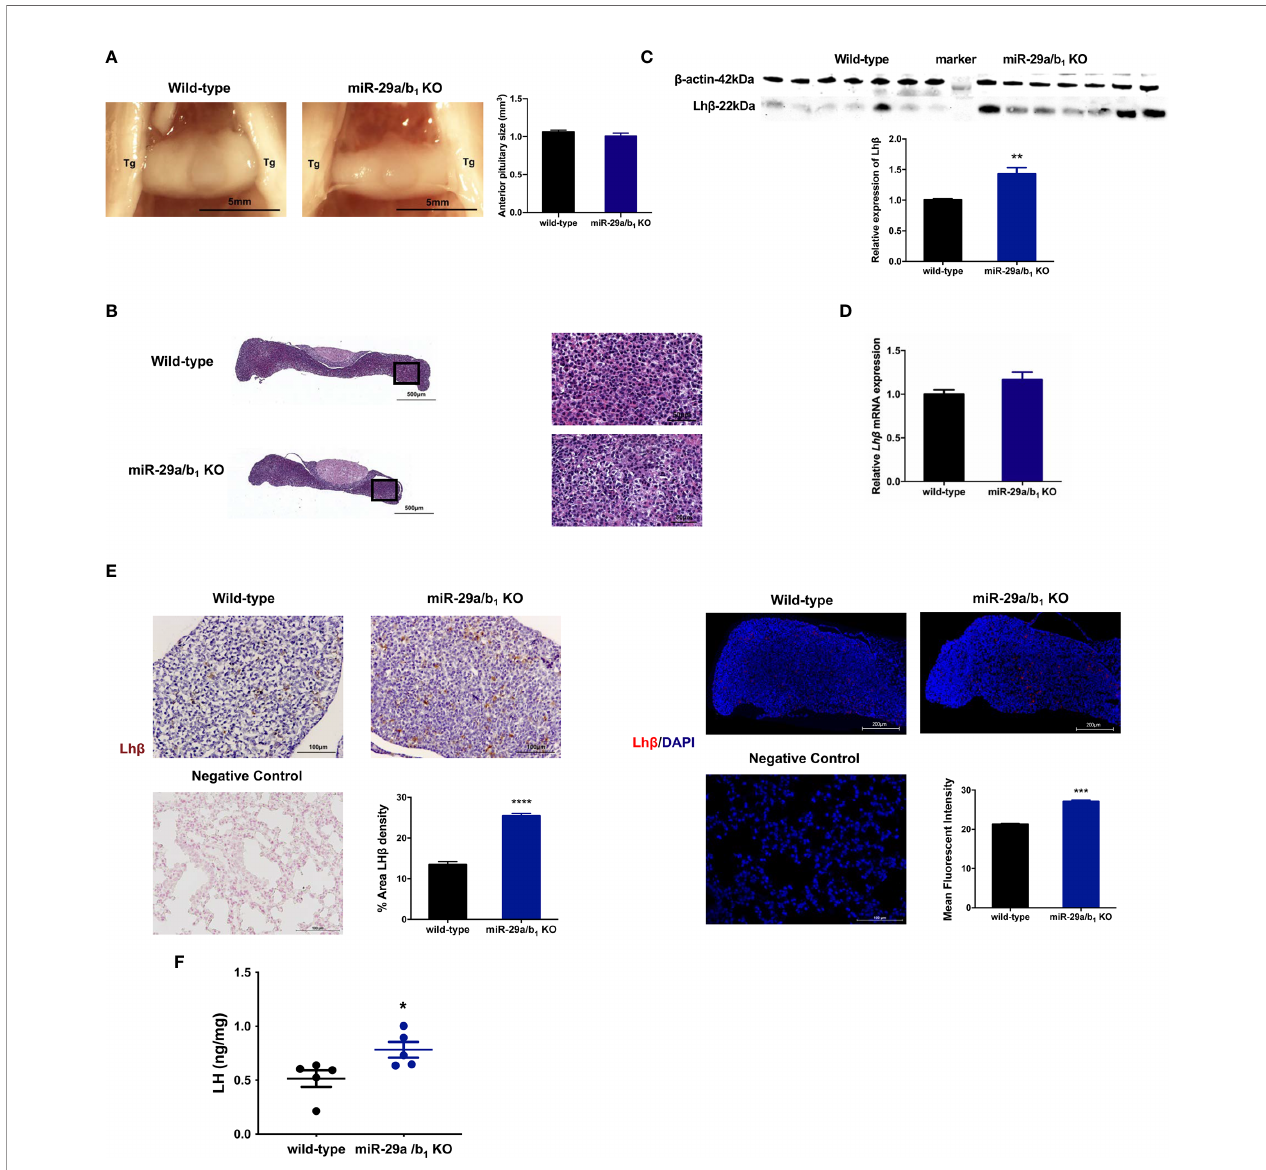
FIGURE 6 | Impairment of Lh b protein export in the pituitary as a de fi ciency of miR-29a/b 1 . (A) Pituitary from female wild-type mice (n=9) and miR-29a/b 1 KO mice (n=5) were photographed in situ during dissection. Trigeminal nerves that fl ank the pituitary are marked as Tg. Scale bar = 5 mm (2x magni fi cation). Anterior pituitary size was statistically analyzed ( p=0.2411 , n=7). (B) The entire sagittal pituitary and higher magni fi cation in the box from wild-type and miR-29a/b 1 KO females are shown. (C, D) LH b protein ( p=0.0019 ) and transcripts ( p=0.1278 ) levels were determined in pituitary tissues from miR-29a/b 1 KO and wild-type mice (n=7). (E) Quanti fi cation of immunoreactivity LH b in pituitary of miR-29a/b 1 KO or control mice (immunohistochemical: wild-type:13.43 ± 0.7927, n=5, miR-29a/b 1 KO: 25.47 ± 0.534, n=4, p<0.0001 ; immuno fl uorescence: wild-type: 21.27 ± 0.147, miR-29a/b 1 KO: 27.11 ± 0.3642, p=0.0001 , n = 3). LH b was not detectable on the plasma membrane of control. Scale bars: 200 m m. Red indicates positive-LH cells, Cell nuclei (blue) were stained with haematoxylin or DAPI. (F) LH proteins relative contents in females. (Wild-type: 0.5147 ± 0.07769, miR-29a/b 1 KO: 0.7819 ± 0.07199, p=0.0357 , n=5). * p < 0.05, ** p < 0.01, *** p < 0.001 and **** p <